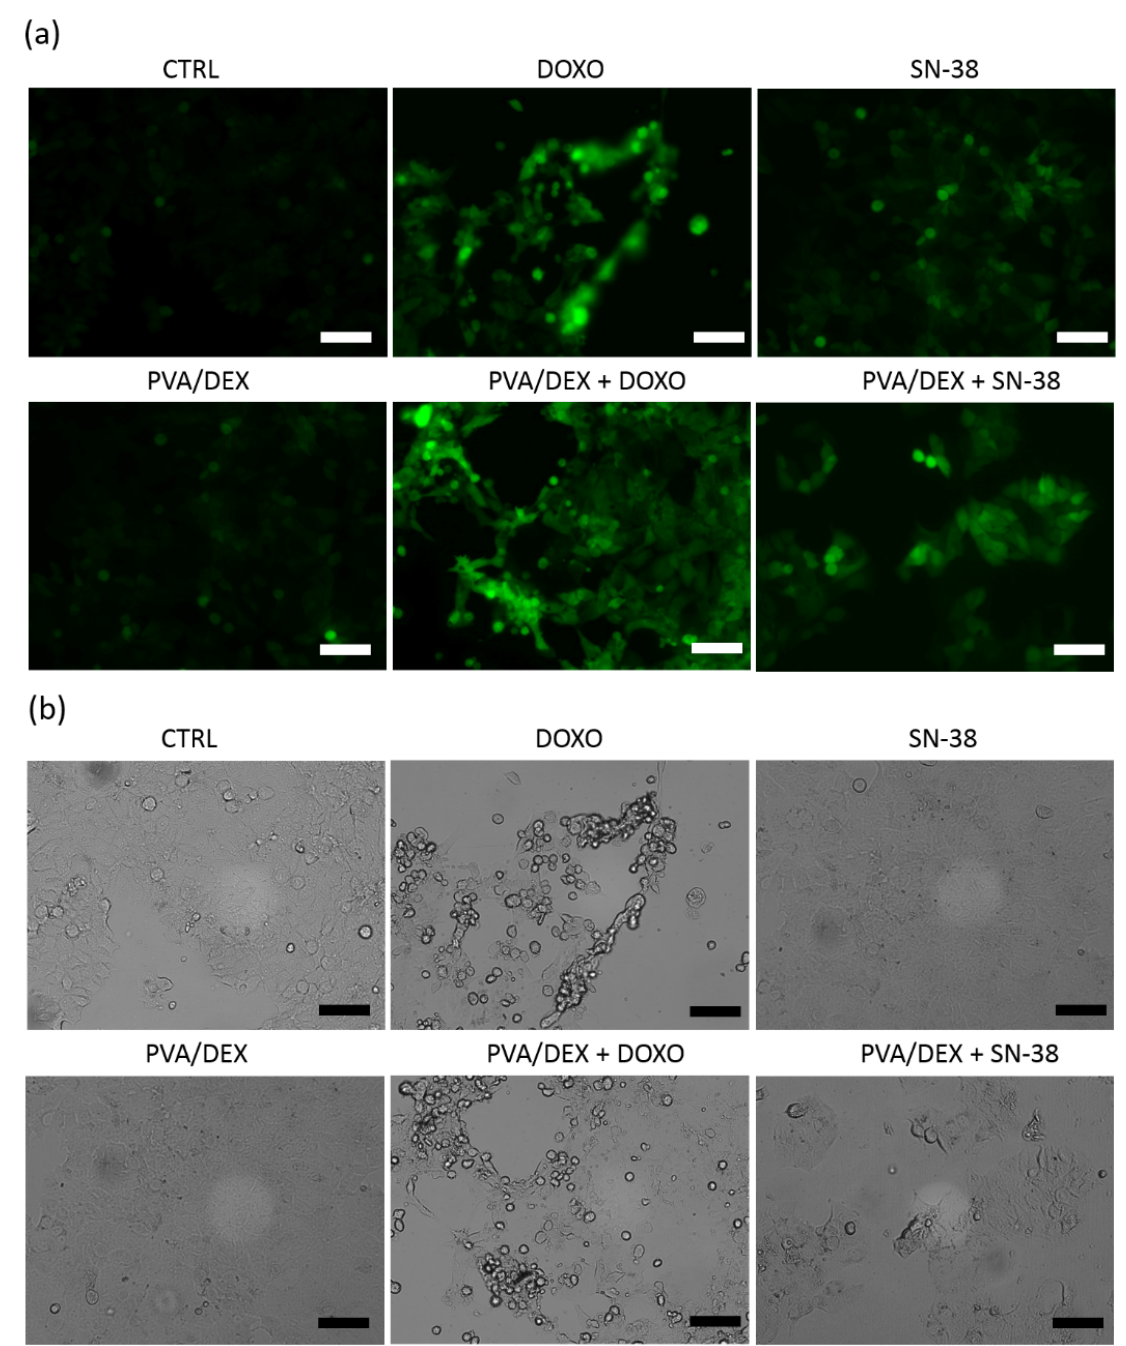
Figure 6. Representative images of DCF staining in MCF-7 cells incubated with either the free drugs or with the PVA/DEX NPs, both empty and loaded. Panels ( a , b ) correspond to the fluorescence channel and to the bright field, respectively. The scale bar corresponds to 100 µm.